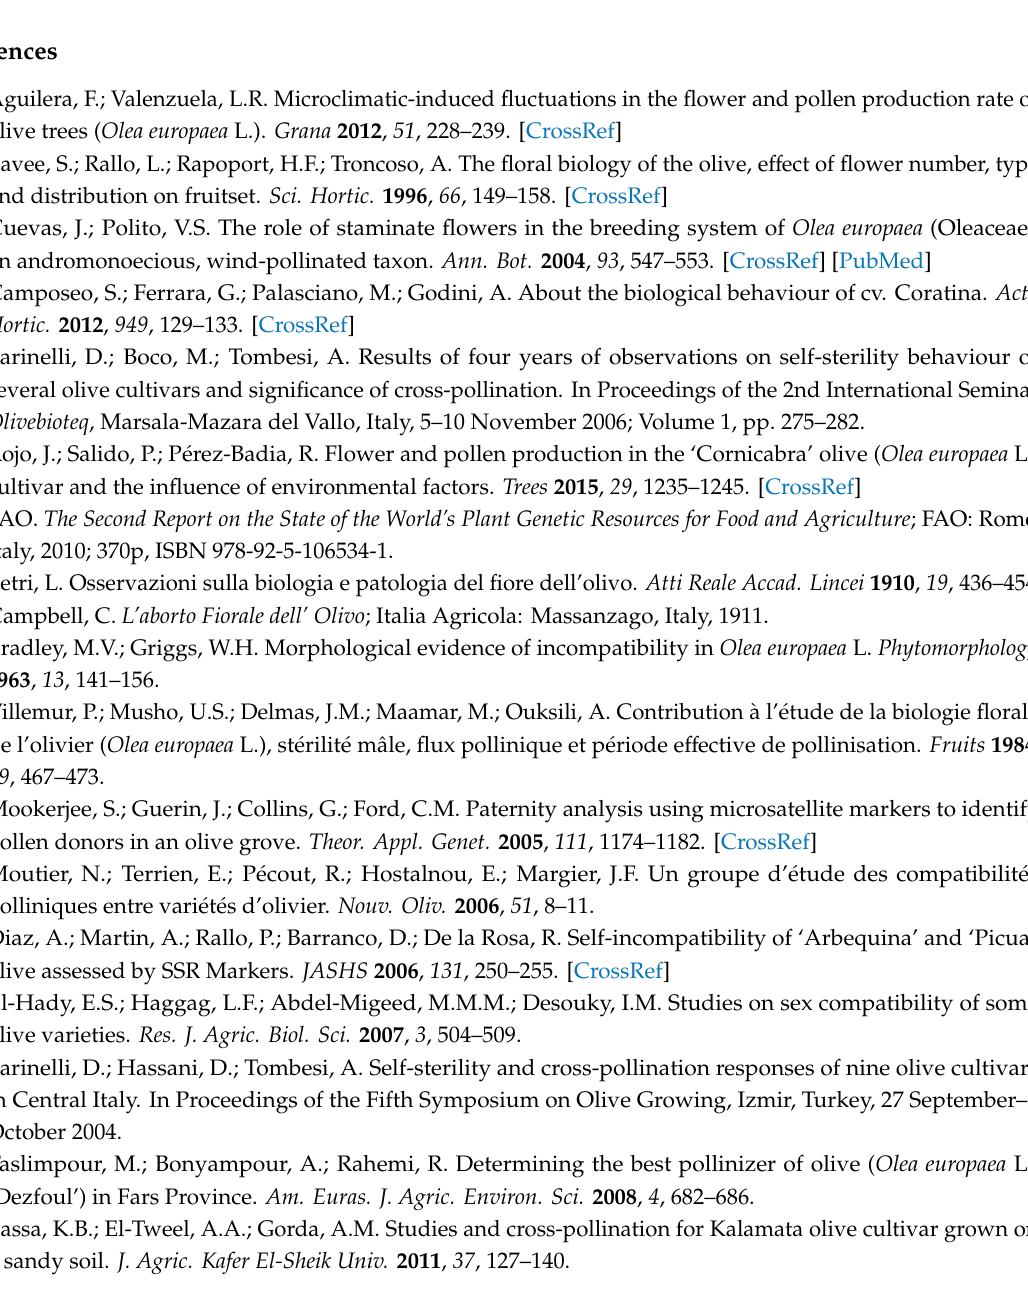
Table S1: Models for predicting flowering date which were tested, Table S2: Results of the cross validation test for all the models under study, Table S3: Specific cumulated heat requirement for each cultivar under study, calculated by fitting SW1 model (Table S1) to